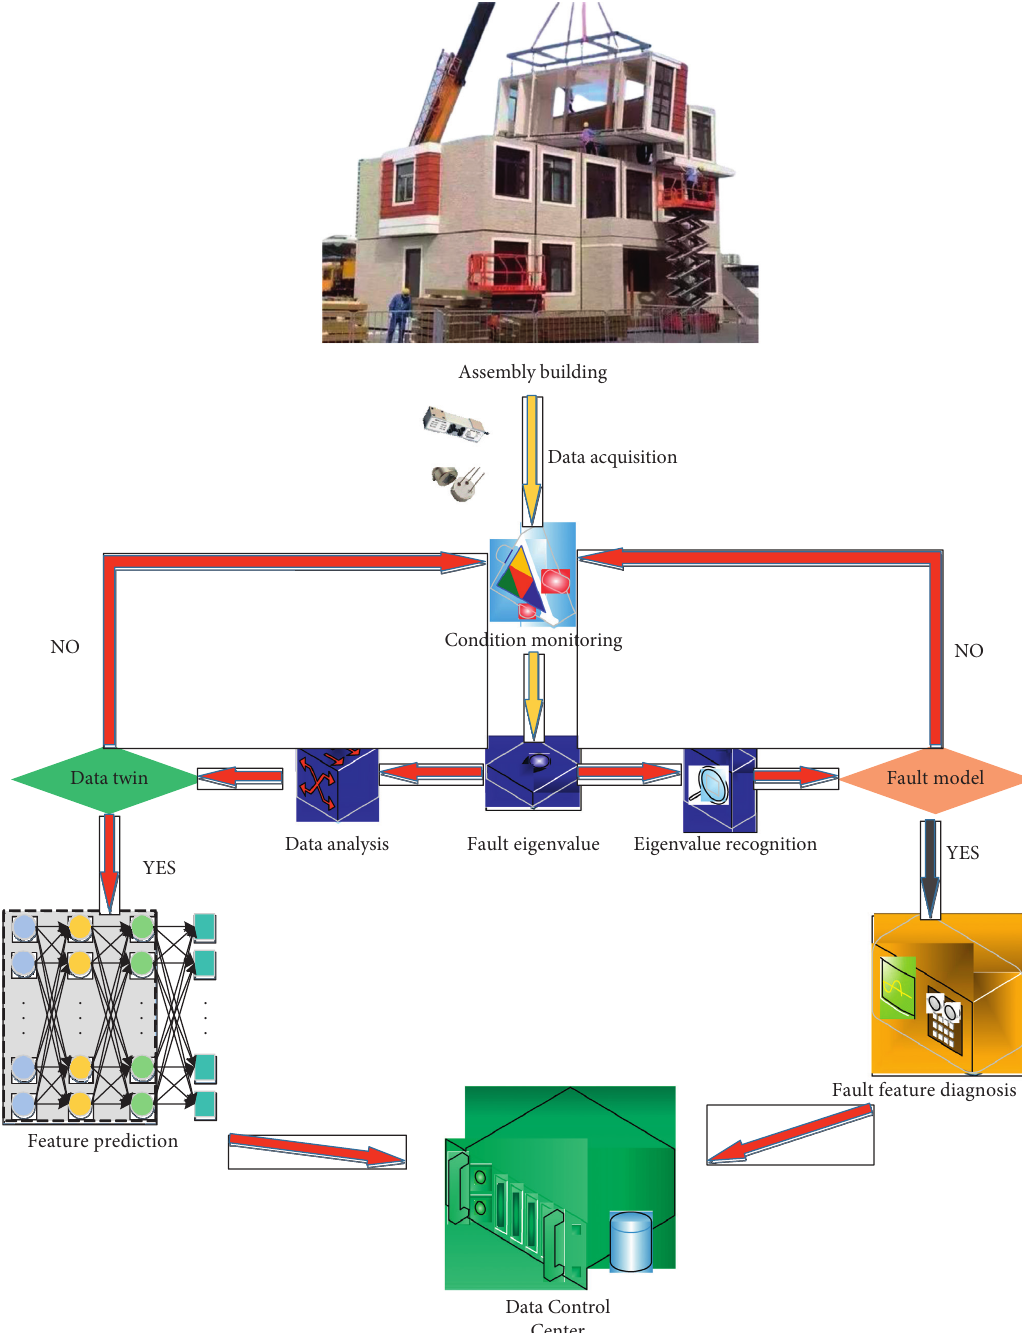
Figure 3: Operation and maintenance of the prefabricated building system for